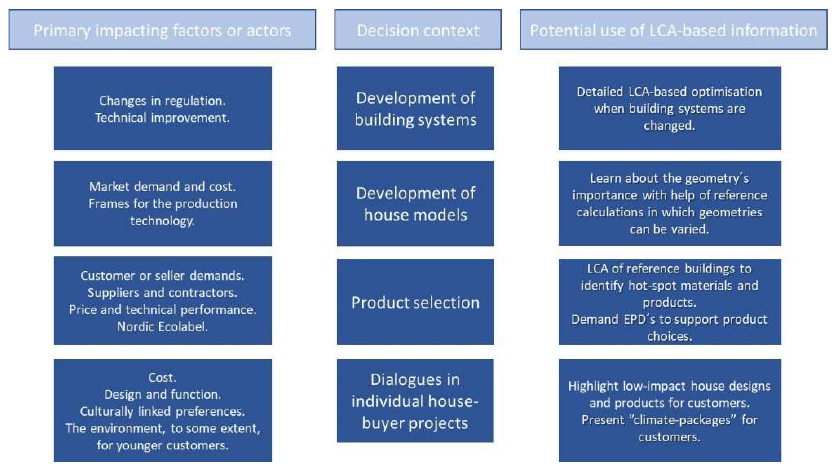
Figure 1. Summary of impacting factors and external actors in decision contexts of the single-family homes industry and potential use of LCA-based information to support low-carbon construction.